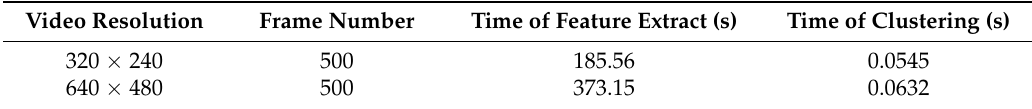
Table 5. The time consuming of the